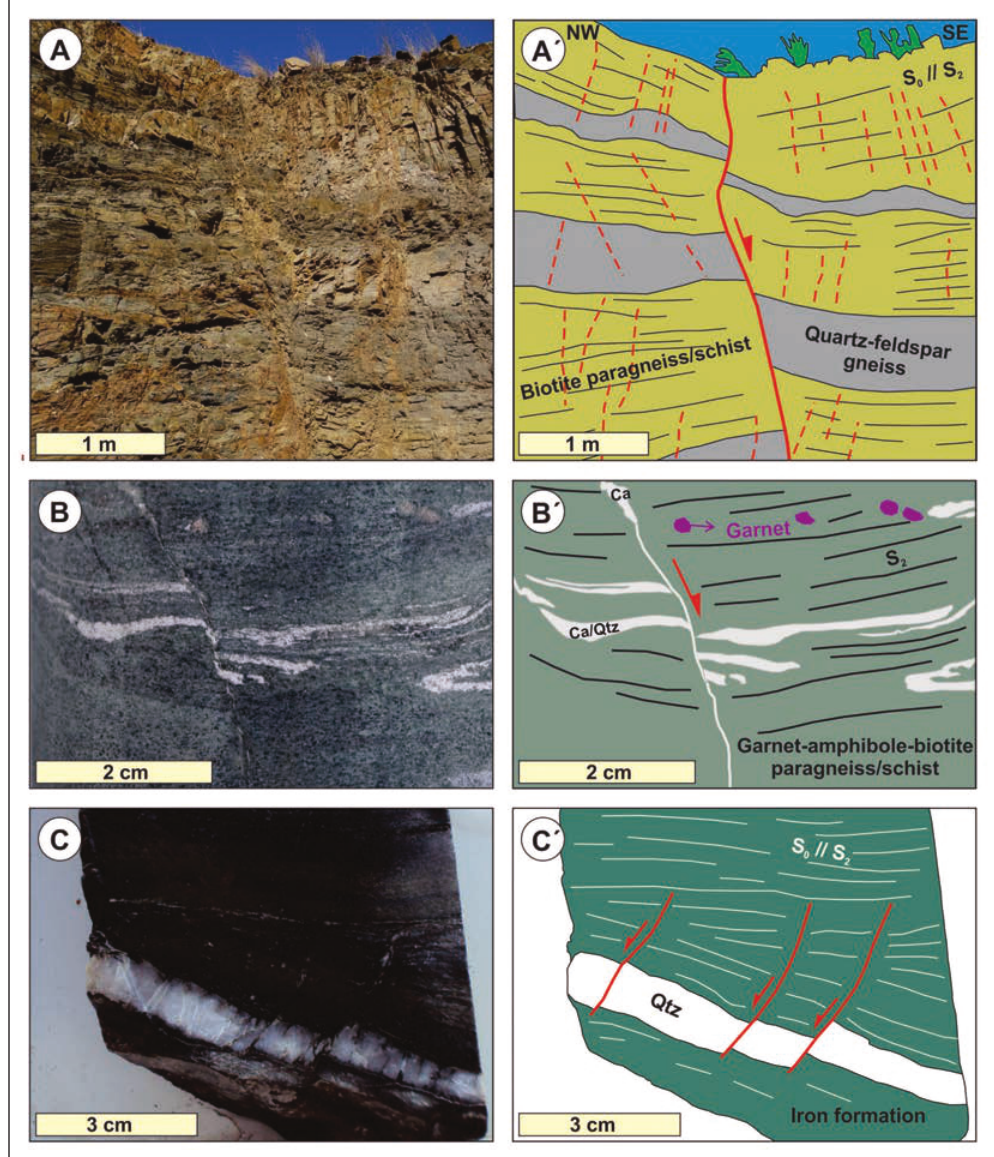
Figure 9 - Photos of structural features of the brittle regime in the rocks of the Jucurutu Formation, in the Saquinho mine region (A, B, and C) and respective interpretative drawings (A’, B’, and C’). (A) Subvertical fault (80°/50°Az) affecting paragneiss and iron formation in an open pit operation; (B) and (C) drill-cores showing normal faults with centimeter heave superimposed on paragneiss/schist (B) and iron formation (C). Qtz = quartz; Ca = carbonate